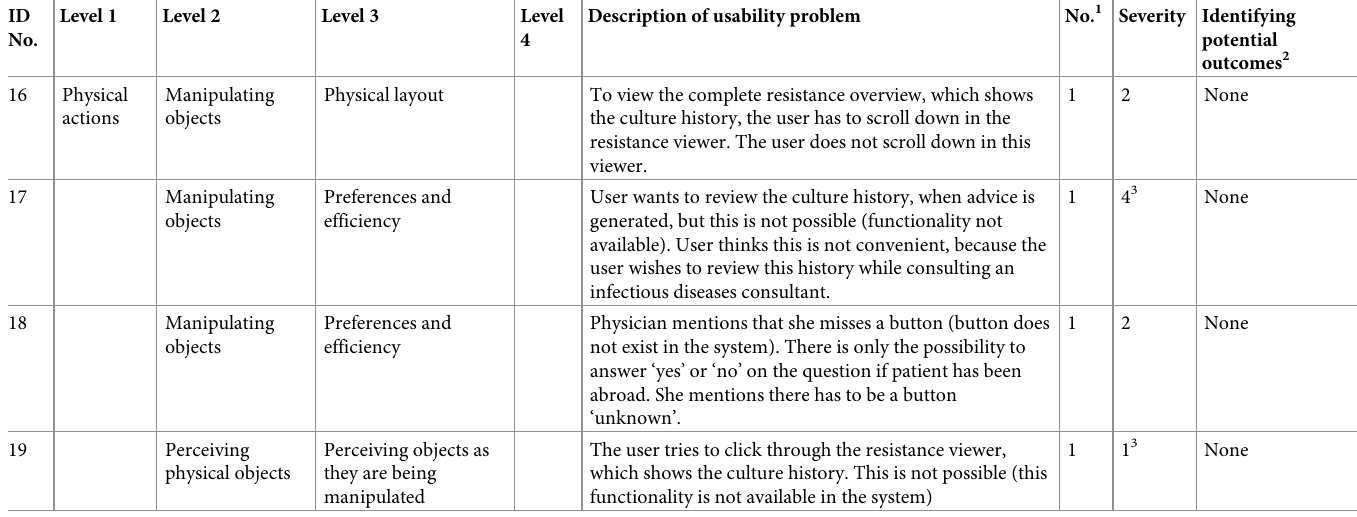
Table 3. Usability problems in the UAF physical action phase with their severity and potential effect on task outcome. ID Level No.